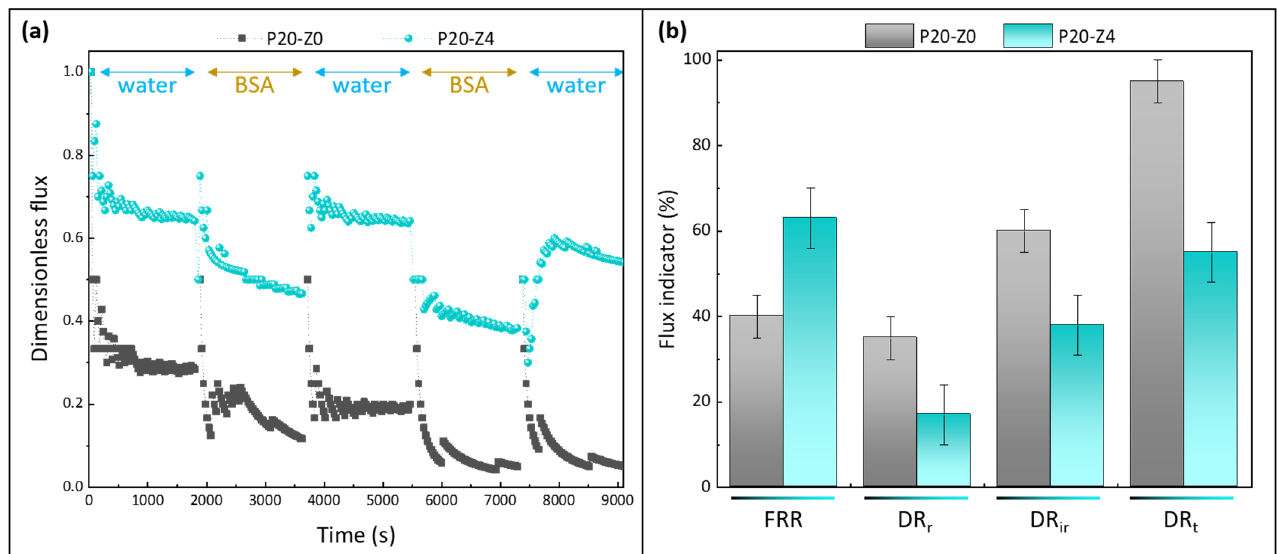
Figure 12. Effect of zwitterionic copolymer on the resistance of membranes to protein fouling during water/BSA cyclic filtration. ( a ): dimensionless flux; ( b ): flux indicator ratios (FRR: flux recovery ratio; DR r : reversible decline ratio; DR ir : irreversible decline ratio; DR t : total decline ratio). n = 3 independent tests were carried out.